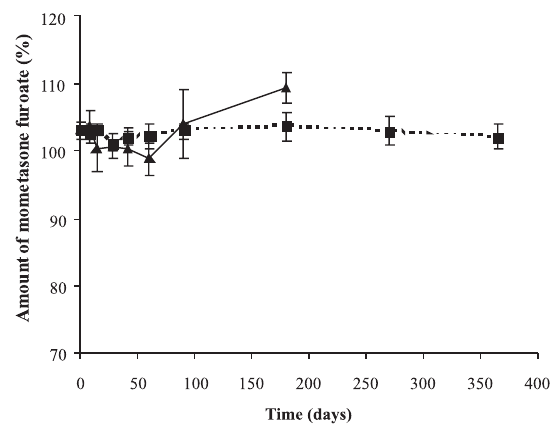
FIGURE 2 - Percentage of mometasone furoate in the lots stored at room temperature (■) and in the lots stored in the oven (▲), (mean ± SD, n = 3).